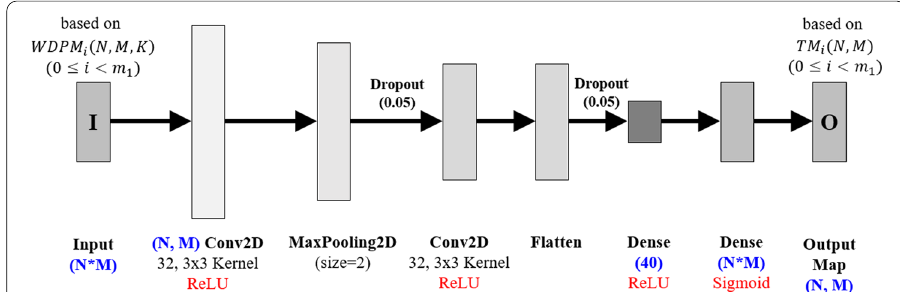
Fig. 3 Architecture of deep learning model for common throughput maximization: we use convolutional neural network (CNN) [19] for our